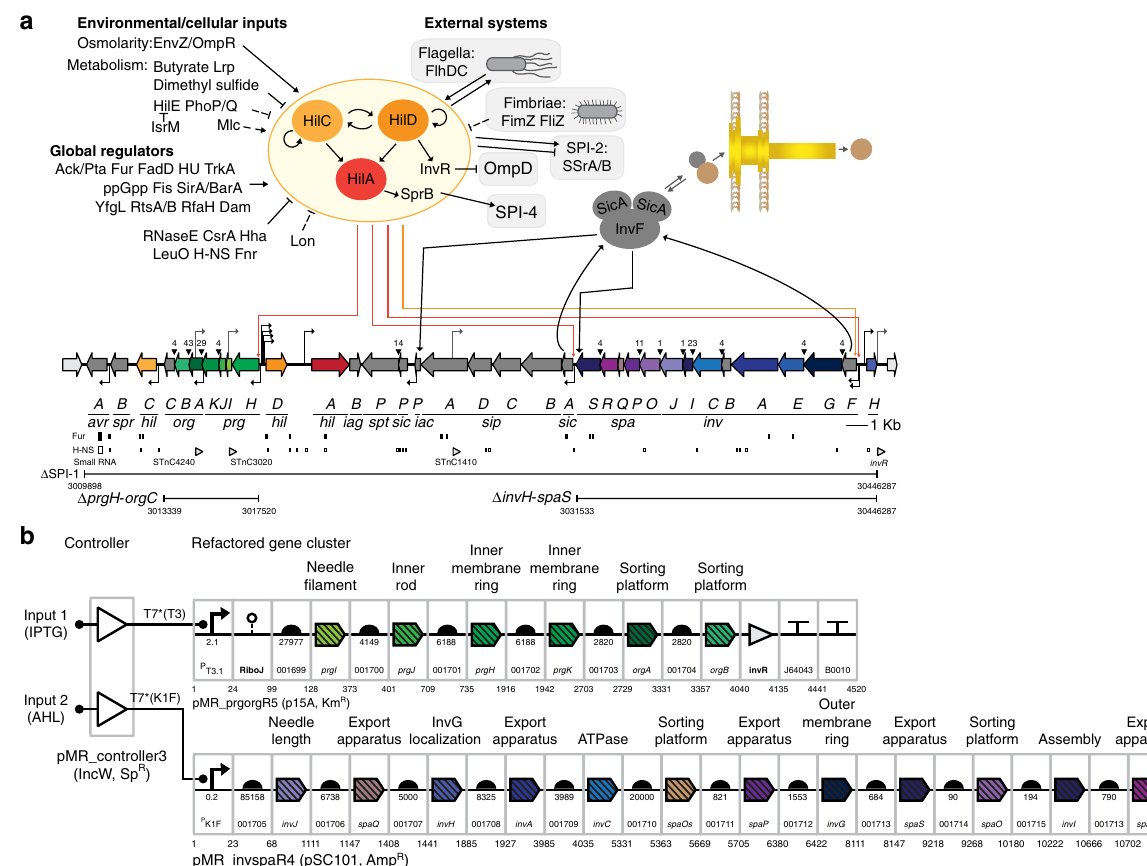
Figure 1 | The native and refactored versions of SPI-1 are compared. ( a ) SPI-1 is shown with the known internal and global regulatory network 24,58,67 . Transcription factors are shown in red/orange, effectors/chaperones are shown in grey, genes outside SPI-1 are white, and structural genes are coloured by operon occupancy. Transcriptional start sites for forward/reverse promoters are indicated by arrows above/below the DNA line 22,25,58,68 . Regions of translational coupling are marked with triangles and the number is the length of overlapping DNA. Predicted H-NS and Fur operator sites are shown 68 . Small RNAs are shown as empty triangles 25 . Knockouts described in this manuscript are shown along with the beginning and end nucleotide sequence, numbered to correspond to the LT2 genome sequence (NC_003197.1). ( b ) The complete refactored SPI-1 is shown, including the controller ( prg - org R5 inv - spa R4 and pMR_controller3). Each genetic part is surrounded by a grey box with the SBOLv (www.sbolstandard.org) symbol and SynBERC Registry (registry.synberc.org) part number at the bottom (each number is preceded by a SBa_). The number under the symbols shows the relative strengths of promoters and RBSs (Methods). The sequences of all genetic parts, including codon optimized genes, are provided in Supplementary Table 6. The plasmids containing the controller and two refactored operons are shown, with the full maps described in Supplementary Figs 17 and 18. The complete refactored system is shown, with intermediate constructs and strains described in Supplementary Table